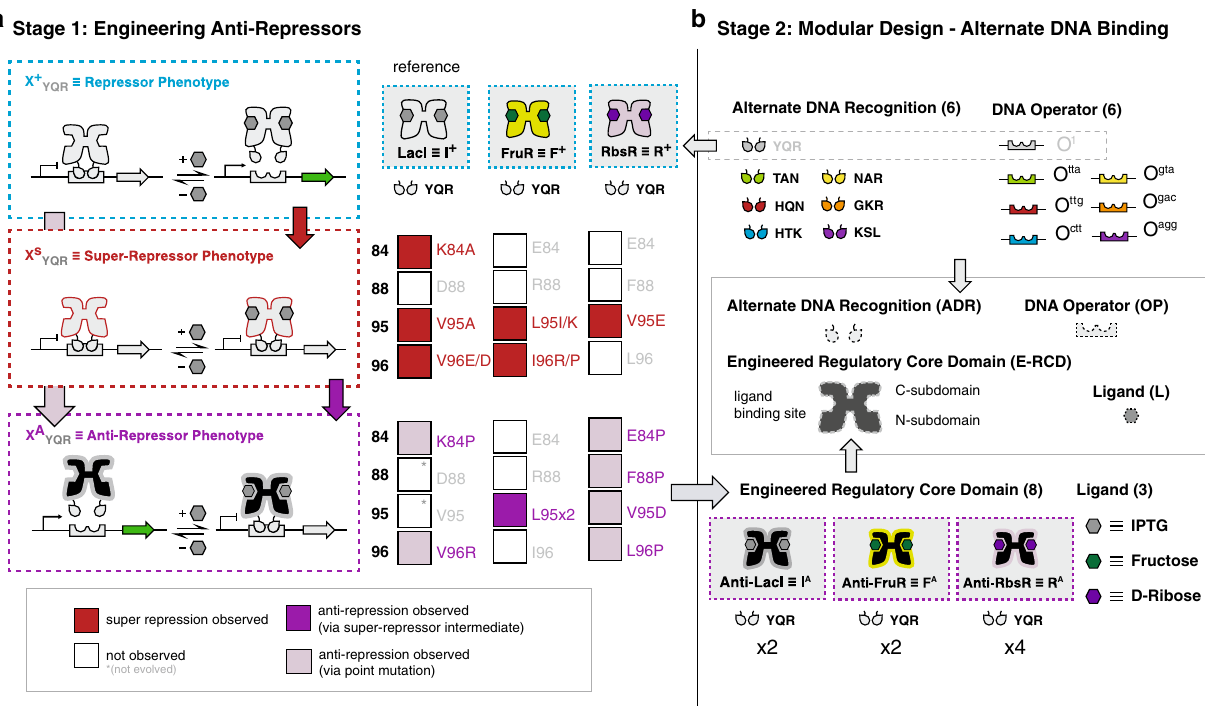
Fig. 2 Work fl ow for engineering systems of transcriptional anti-repressors. a Left panel illustrates stage one of the work fl ow, where anti-repression was conferred to wild-type repressor scaffolds. We began with the repressor regulatory core domain (RCD) adapted with the wild-type LacI DNA-binding domain (DBD), YQR (X + YQR ). The repressor phenotype (X + ) allows gene transcription only in the presence of the inducer ligand, which causes the TF to dissociate from a cognate operator, permitting RNA polymerase function. A sequence alignment to the reference repressor, LacI ≡ I + , informed which residues in FruR ≡ F + and RbsR ≡ R + are target positions for rational engineering of super-repressors. The super-repressor phenotype (X S ) inhibits gene transcription regardless of the presence of the inducer ligand by constitutively binding to the operator. Site-saturation at positions corresponding to LacI K84, D88, V95, and V96 yielded super-repressor phenotypes in homologues F + YQR and R + YQR . This follows the route of the red arrow (X + → X S ). In addition, site-saturation of R + YQR resulted in single-mutation R A YQR anti-repressors, effectively bypassing the R S intermediate (following the path of the light purple arrow - X + → X A ). The anti-repressor phenotype (X A ) inhibits gene transcription in the presence of the ligand by binding to the operator. Anti- repression was also conferred via laboratory evolution, introducing compensatory mutations to the X S intermediate (red, then dark purple arrow: X + → X S → X A ) yielding F A YQR TFs. b Right panel illustrates stage two of the work fl ow, where modular design was used to adapt engineered RCDs (E-RCDs) with alternate DNA recognition (ADR). E-RCDs from stage one, giving anti-repressor responses to ligands IPTG, fructose, and D-ribose were used as components of regulatory proteins. A regulatory protein consists of (i) an RCD, which is responsible for ligand binding and allosteric signal transmission and (ii) a DBD, which allows interaction with a DNA operator. We selected six ADR modules to adapt to our E-RCDs, which we anticipated would confer interaction with six orthogonal cognate operators, with cognate interactions matching in color. ADR is in addition to YQR | O 1 interactions, with which the E-RCDs were originally